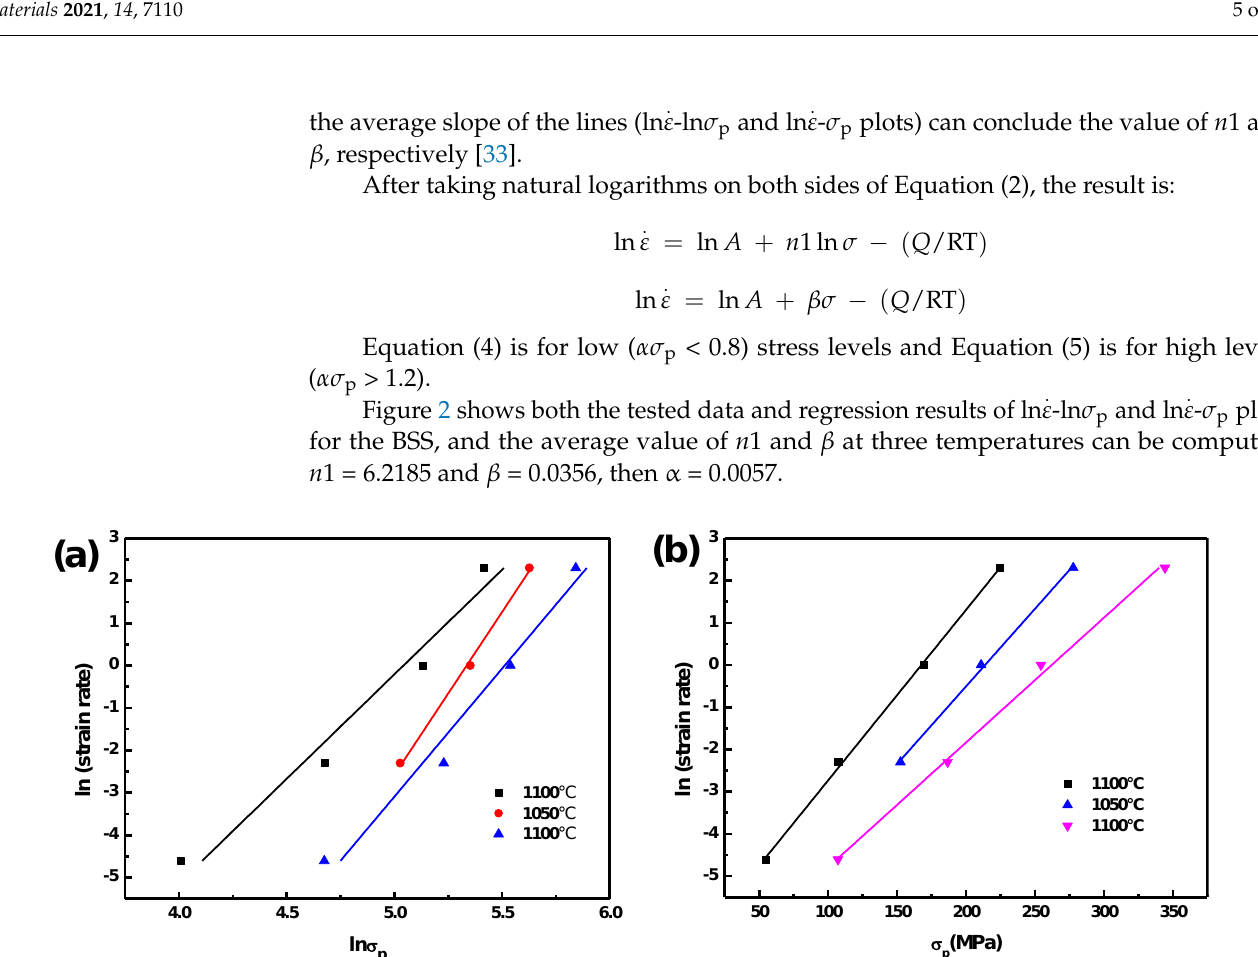
Figure 2. Relationship between ln 𝜀̇ and ( a ) ln σ p ; ( b ) σ p .